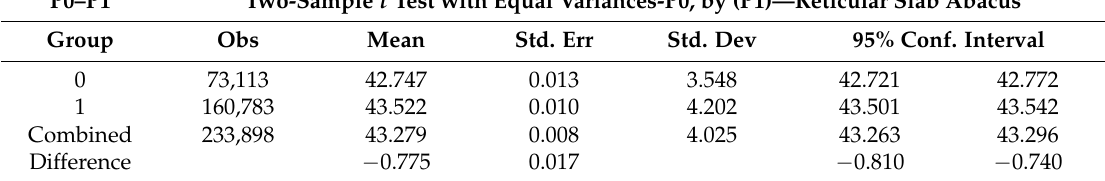
Table 3. Results: P0 by P1: Variability 775 nT between 0 and 1 with p -value: 0.005.